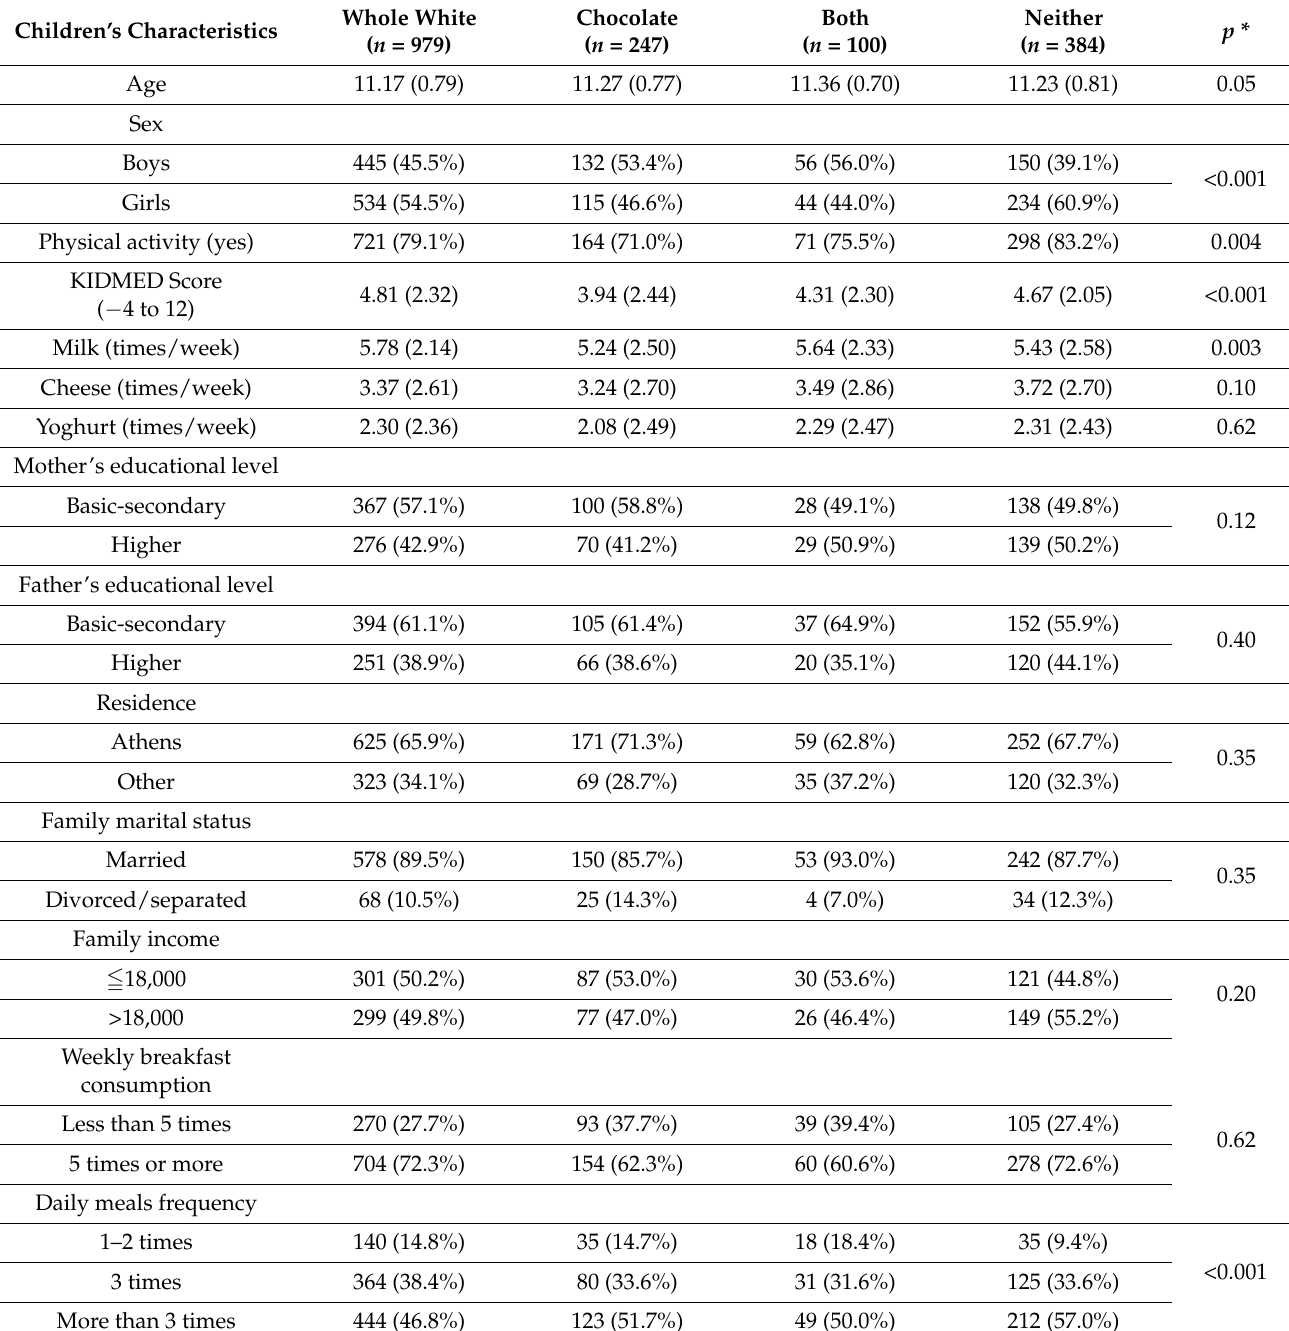
Table 2. Children’s socio-demographic characteristics and lifestyle habits, by milk consumption characteristics (type of